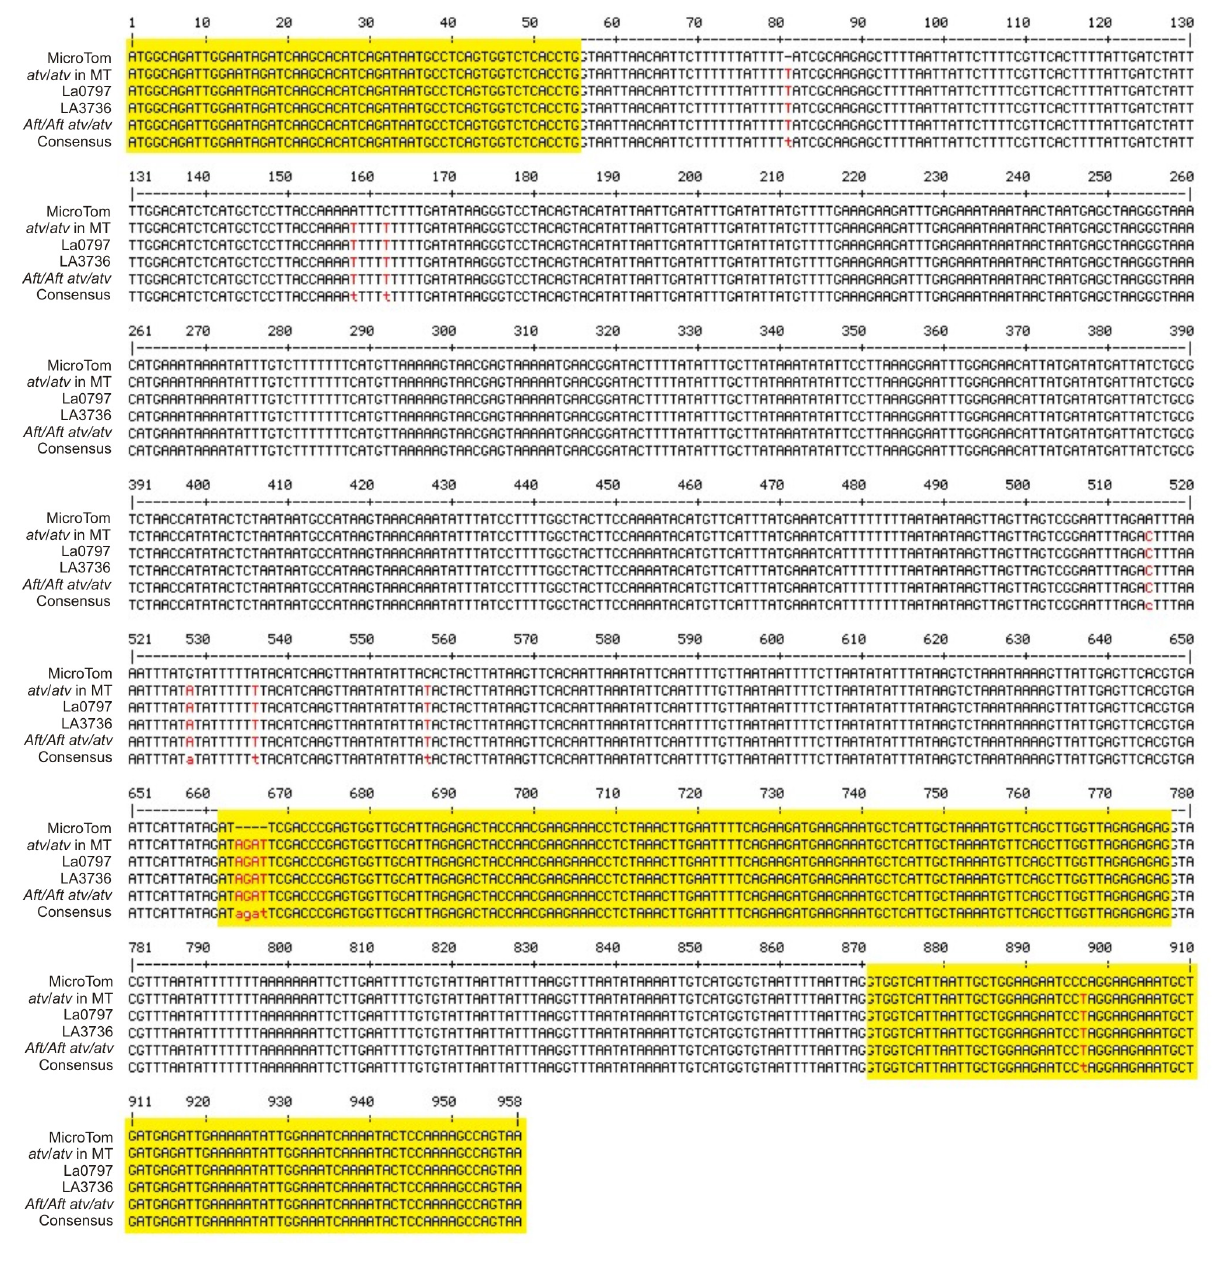
FIGURE 2 | atv mutation in the gene Solyc07g052490 . Multiple alignment of the gene Solyc07g052490 (from start to stop codon) sequenced in different genetic backgrounds: MicroTom (MT), atv / atv in MT background, atv / atv in VF36 background (accession LA0797), atv/atv in Ailsa Craig (AC) background